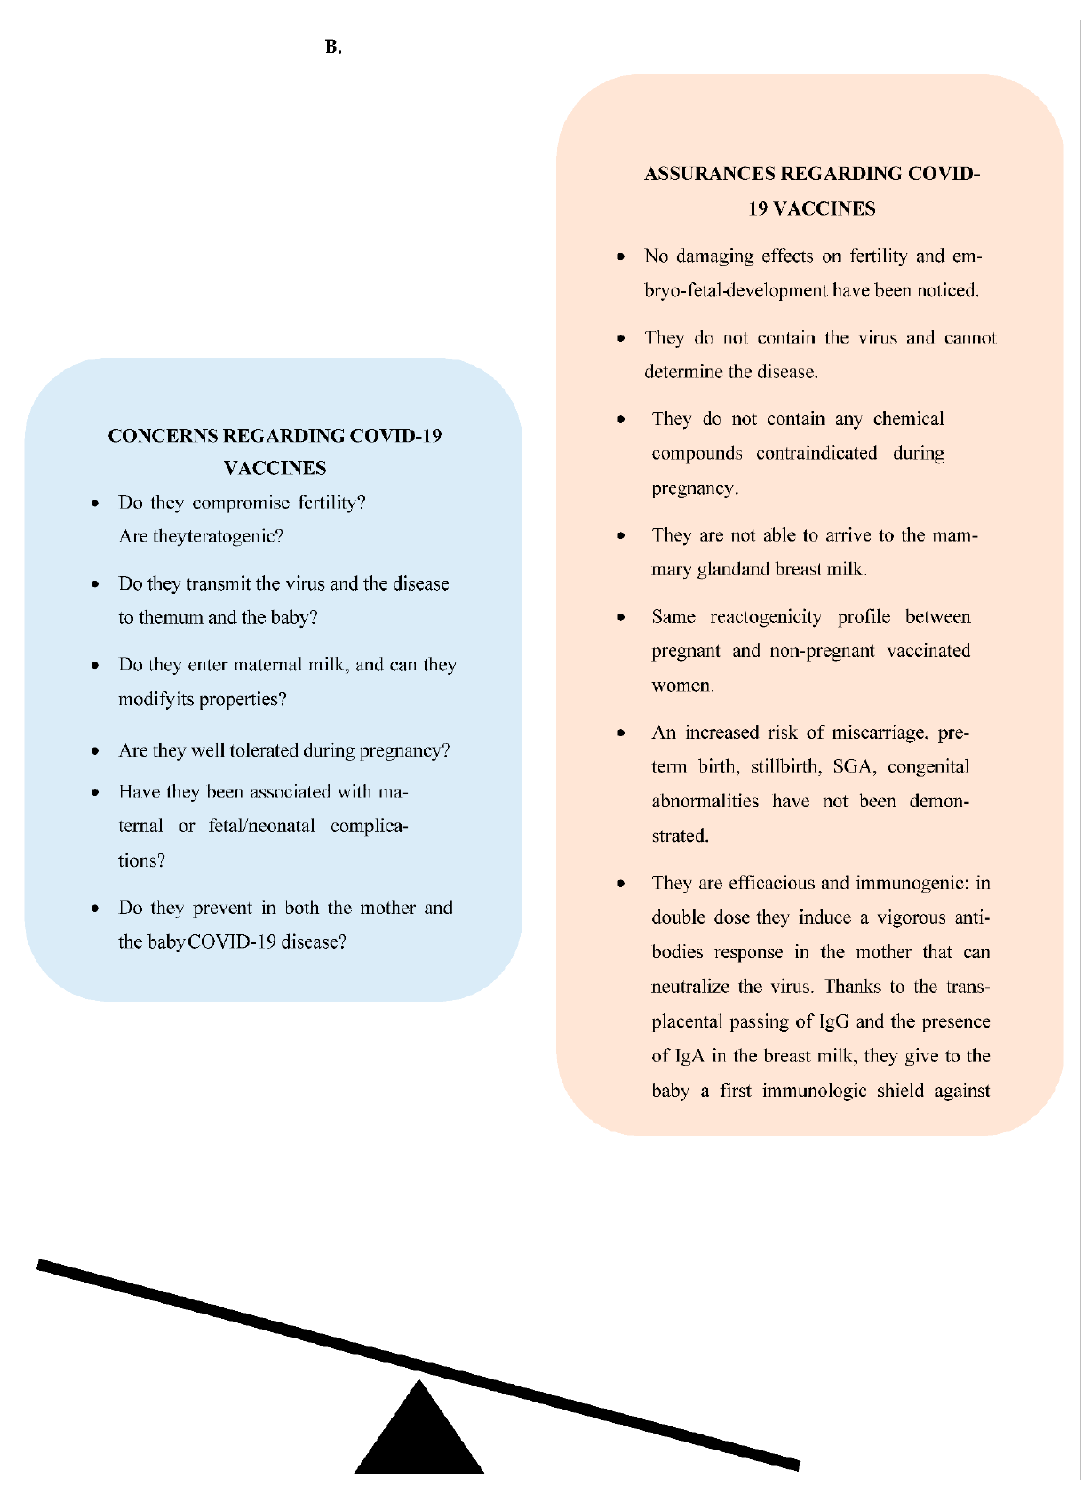
Figure 1. ( A , B ). The current WHO recommendations ( A ) and the main concerns and assurances regarding the anti-COVID-19 vaccination ( B